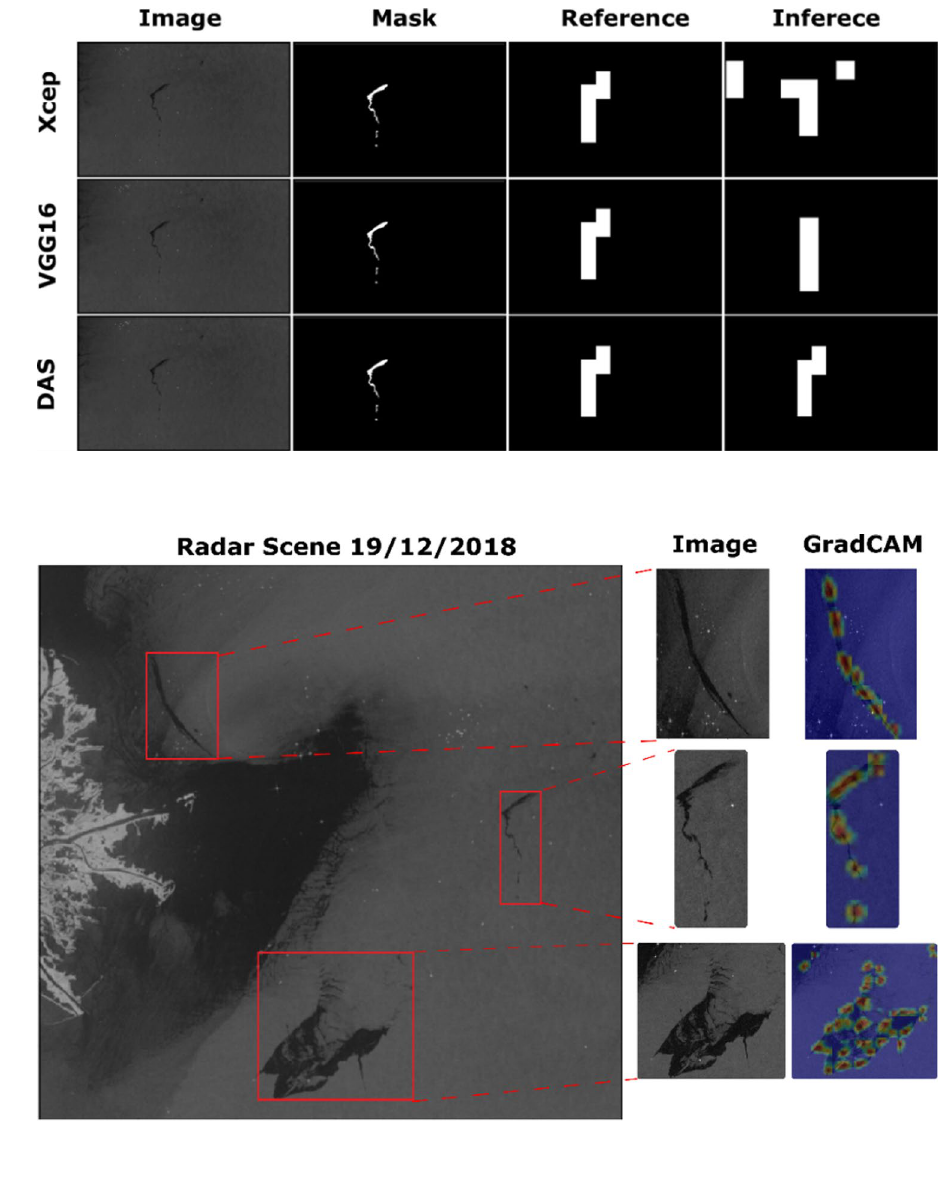
Fig. 12 Inference results using the Xception, VGG16 and DAS models with an image from the Oil Spill dataset. From left to right, the original SAR image (VV polarization, 19/03/2018)